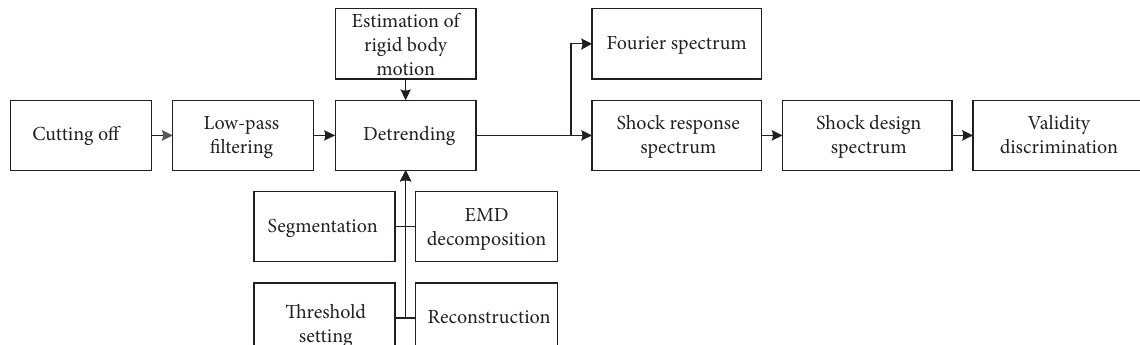
Figure 15: Flow chart of the acceleration signal processing method.